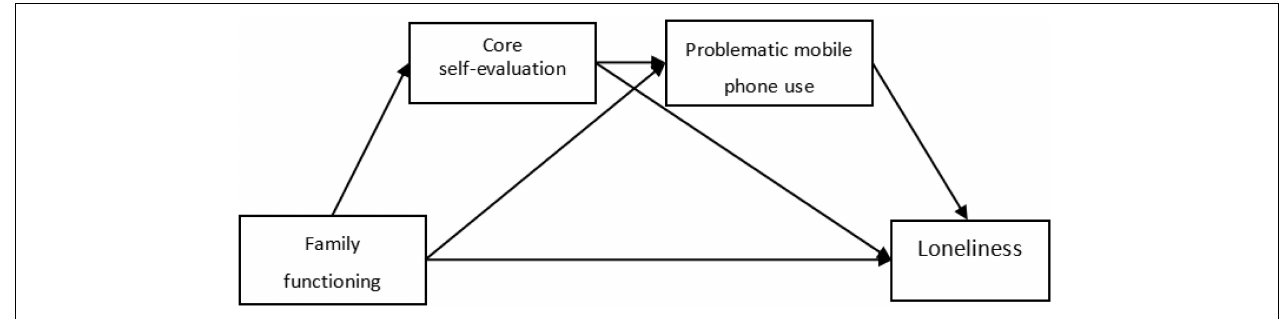
FIGURE 1 | Hypothetical model paths of family functioning, core self-evaluation, problematic mobile phone use, and loneliness.